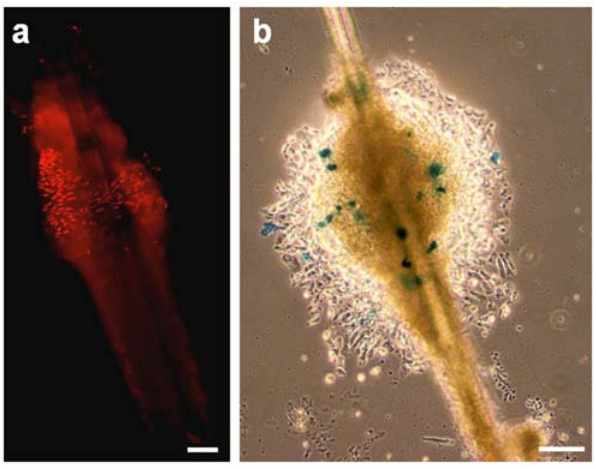
Figure 1. Transfection of MCs from rat vibrissae. MCs are densely represented in the upper part of the vibrissal outer root sheath as